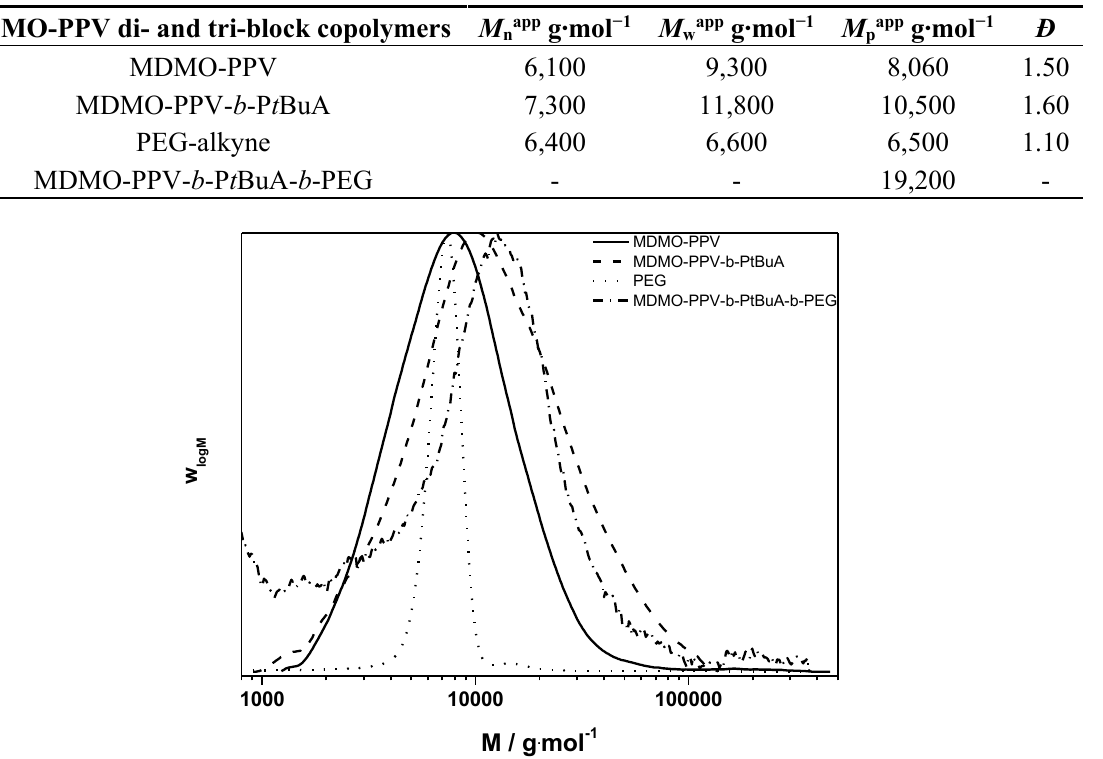
Table 7 . Average molecular weights and Đ for the MDMO-PPV- b -P t BuA- b -PEG triblock copolymers and its precursors.